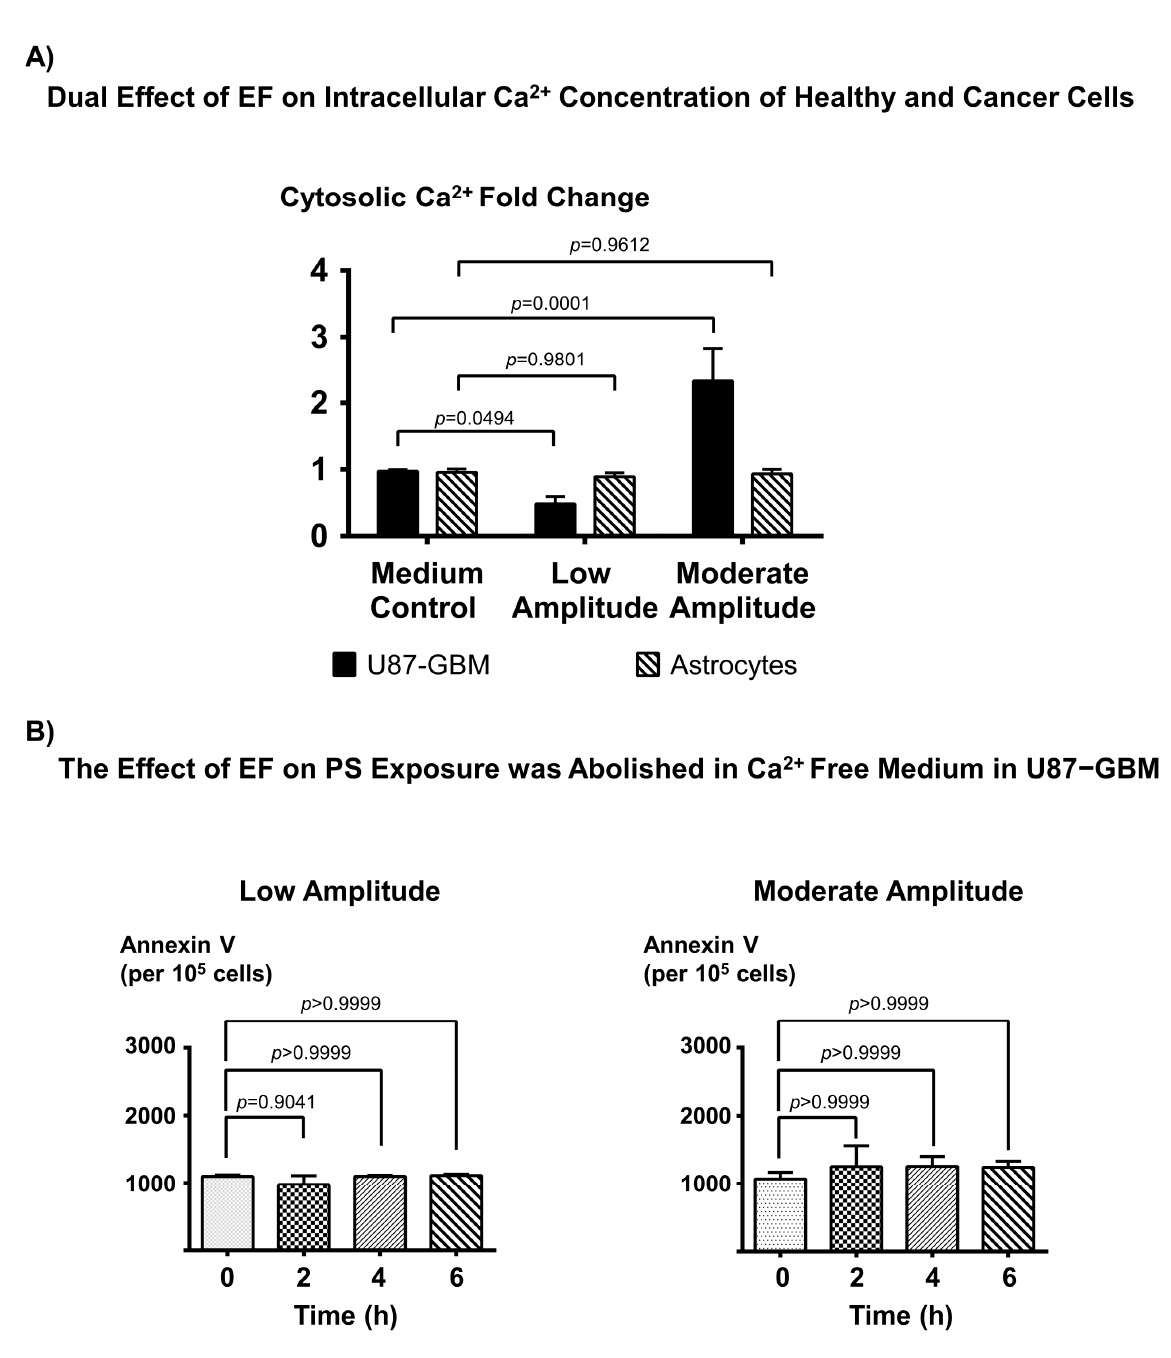
Figure 3. The electric field differentially regulates the intracellular Ca 2+ levels in cancer cells. ( A ) Intracellular Ca 2+ concentration (Fluo-3) fold changes of glioblastoma cells (U87-GBM) and healthy cells (astrocytes) cultured in normal medium (DMEM) following low and moderate amplitude EF stimulation for 6 h. The results show that low-amplitude EF stimulation decreases intracellular Ca 2+ concentration, while moderate-amplitude EF stimulation increases intracellular Ca 2+ concentration in cancer cells. Sample size (n) = 3 ( B ) Flow cytometric measurements of annexin V (FITC